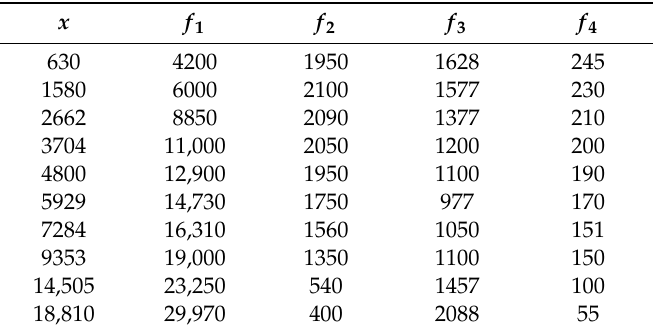
Table 3. Experimental data (matrix